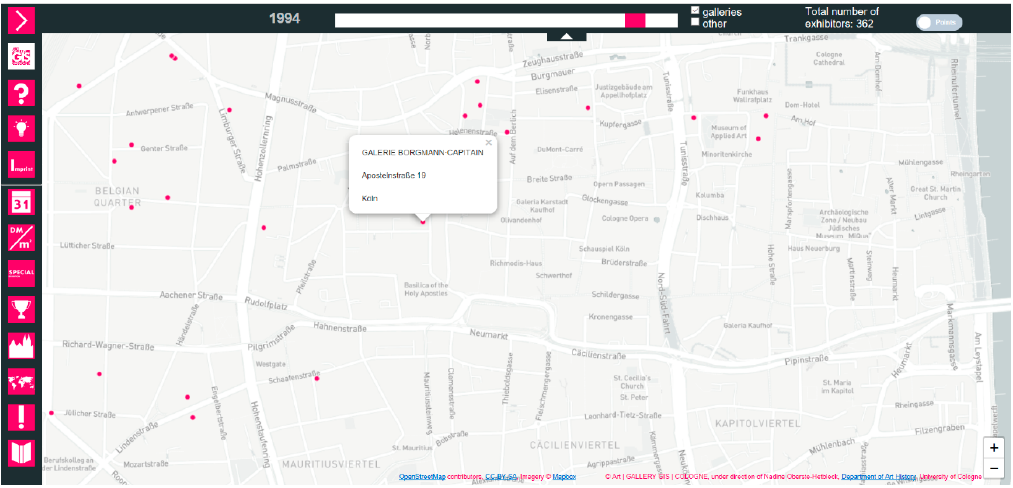
Figure 3. ART|GALLERY GIS|COLOGNE, 1994, pop-up window for the entry Galerie Borgmann Capitain , Cologne, including location information; left navigation bar hidden. Used by permission. © ART|GALLERY GIS|COLOGNE.